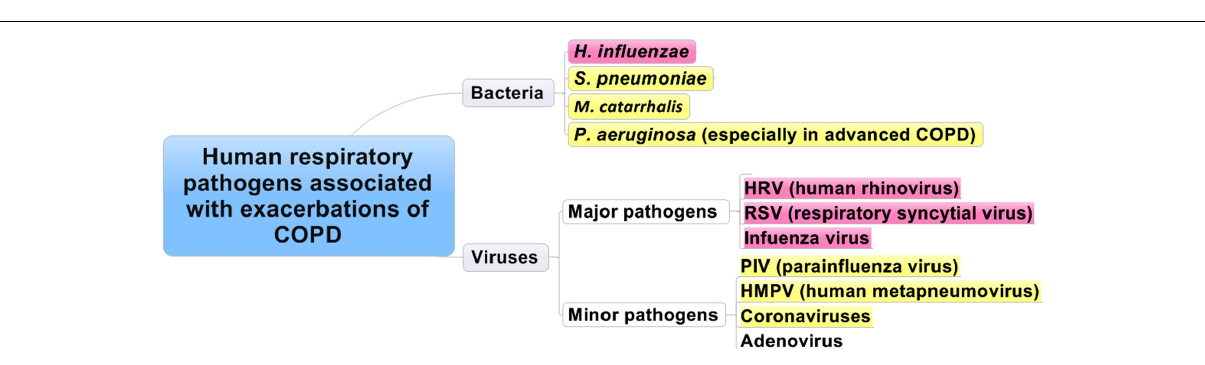
FIGURE 2 | Human respiratory pathogens associated with exacerbations of COPD. Red and yellow columns are the most relevant pathogens in